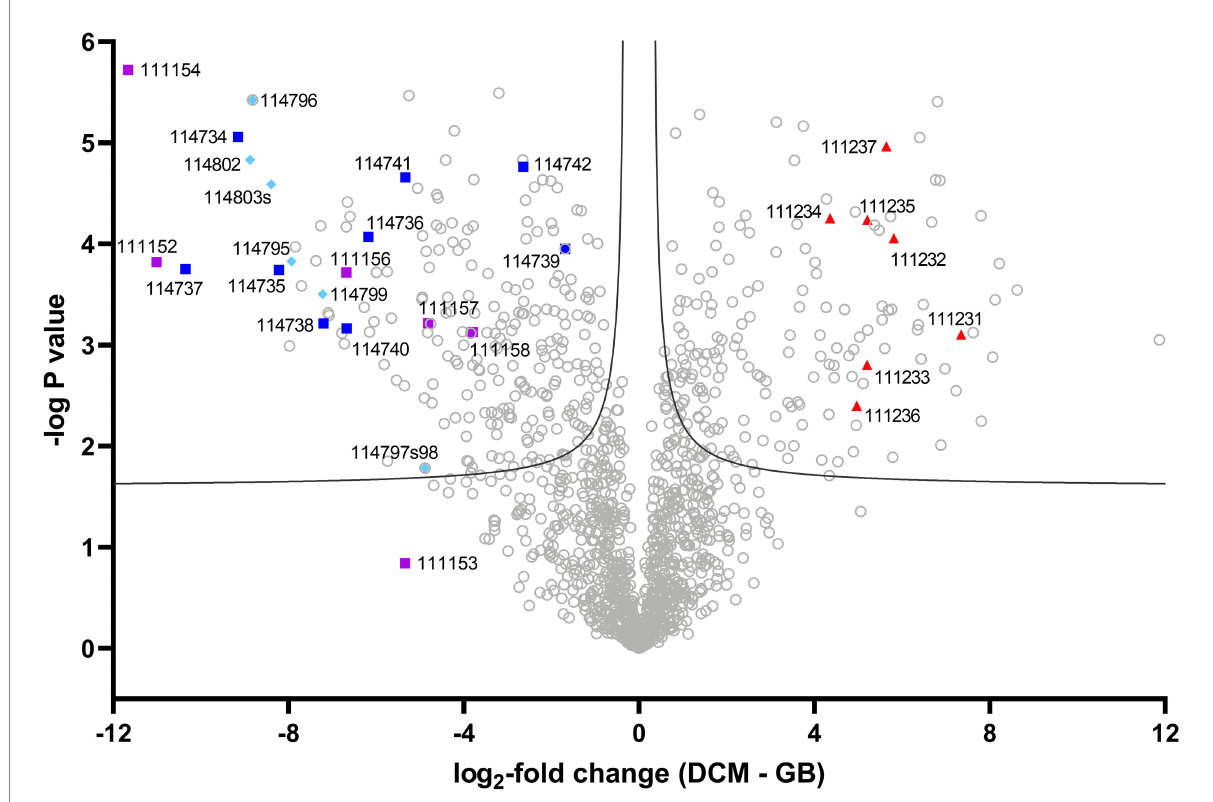
FIGURE 1 Volcano plot of strain DCMF protein expression with DCM and glycine betaine. Log 2 -fold change (LFC) in abundance is shown as the difference between DCM and glycine betaine label-free quantitative intensity. A false discovery rate of 0.01 was the significance boundary, indicated by two lines on the graph. Proteins in the DCM-associated mec cassette are labeled as red triangles, those from the complete glycine betaine methyltransferase gene cluster by dark blue squares, those in the incomplete glycine betaine and/or dimethylglycine methyltransferase gene cluster by purple squares, and those from the sarcosine reductase gene cluster by light blue diamonds. IMG gene loci (prefaced by ‘Ga018035_’) are indicated for these proteins of interest. A full list of all significantly differentially abundant proteins is included in Supplementary Table